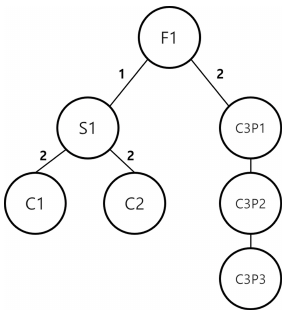
Figure 1. Example of multilevel product structure (Chen et al.